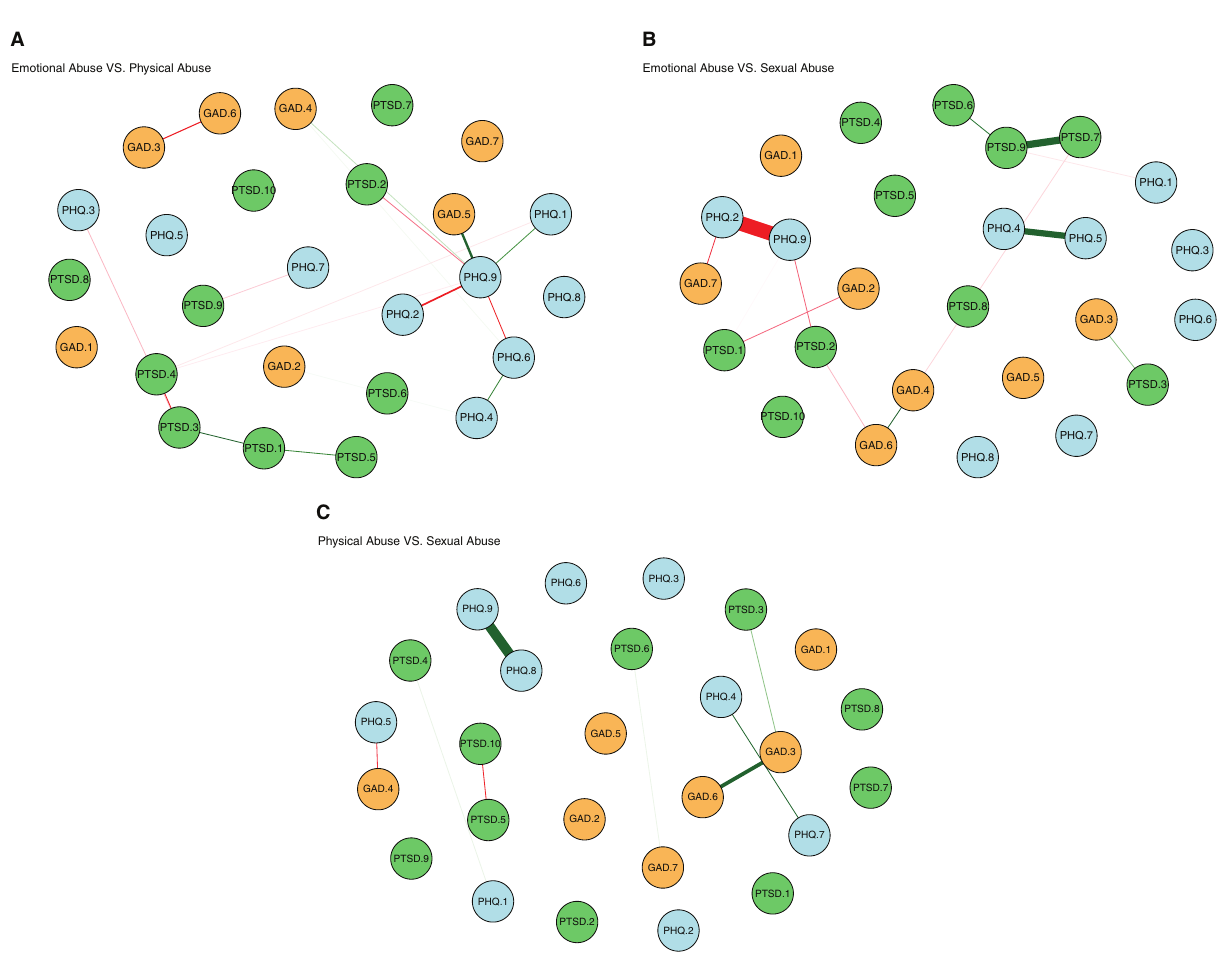
FIGURE3 (A) Edge significant differences between participants with emotional abuse and physical abuse. The red edges denote the stronger associations in emotional abuse group while the green edges denote the stronger associations in physical abuse group. (B) Edge significant differences between participants with emotional abuse and sexual abuse. The red edges denote the stronger associations in emotional abuse group while the green edges denote the stronger associations in sexual abuse group. (C) Edge significant differences between participants with physical abuse and sexual abuse. The red edges denote the stronger associations in physical abuse group while the green edges denote the stronger associations in the sexual abuse